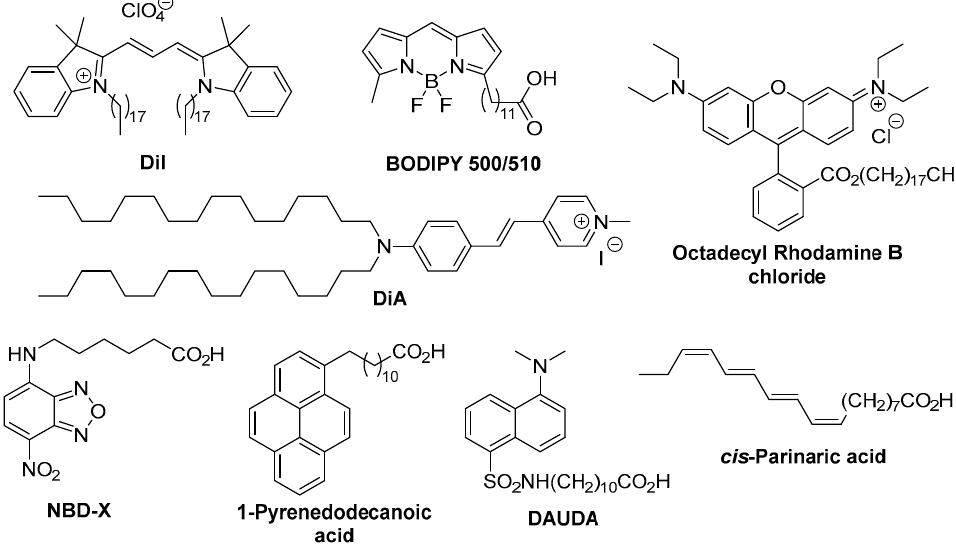
Figure 1. Representative commercially available cell membrane probes.